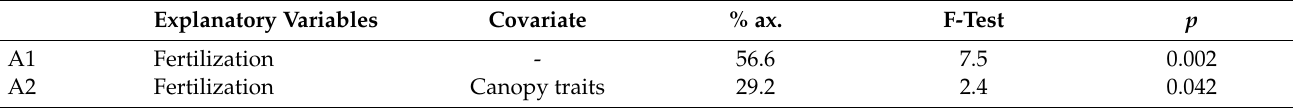
Table 5. Results of redundancy analyses investigating effects of explanatory variables on variability of WSC and starch content in lucerne leaves, stems and whole forage. Descriptions of canopy traits are given in Sections 2.3 and